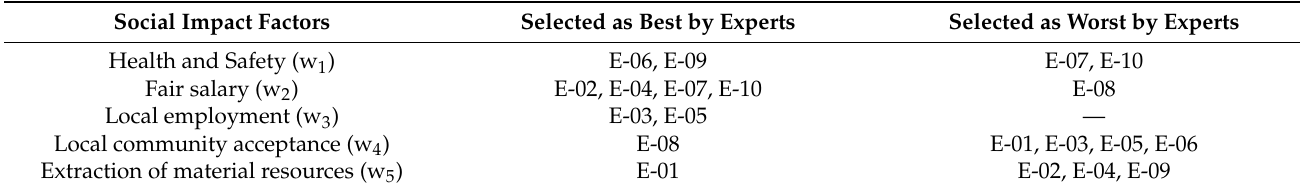
Table 4. Best and Worst criteria for the concrete frame.